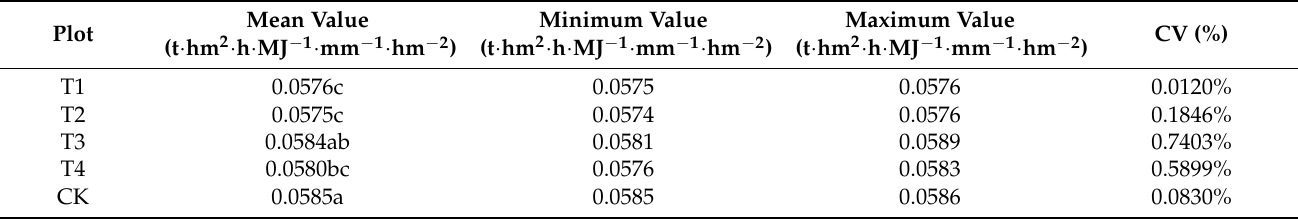
Table 2. Variable parameters of soil erodibility characteristics under different hedgerow